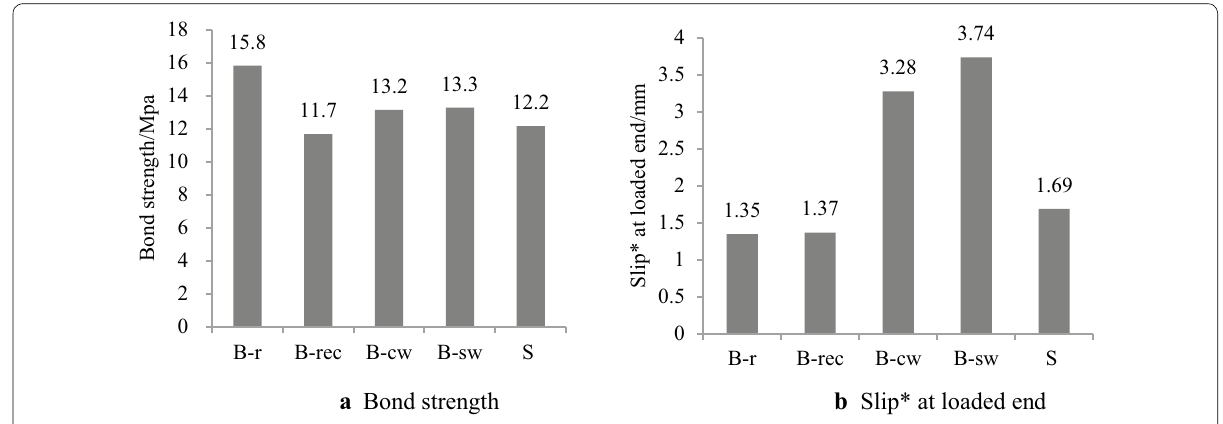
Fig. 7 Comparison of bond behavior between BFRP bars and steel rebar.